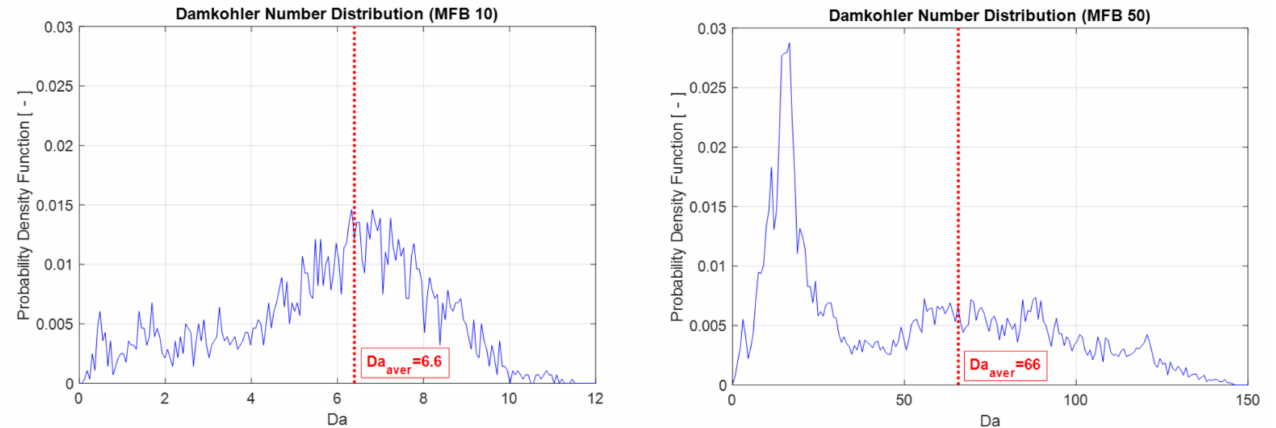
Figure 2. Normalized distributions for volume-weighted Da (blue lines) and mean Da (red line) at 10% ( left ) and 50% ( right ) burnt fraction in an SI engine from [30]. Data are conditioned on the flame brush (0.05 < (cid:101) c < 095